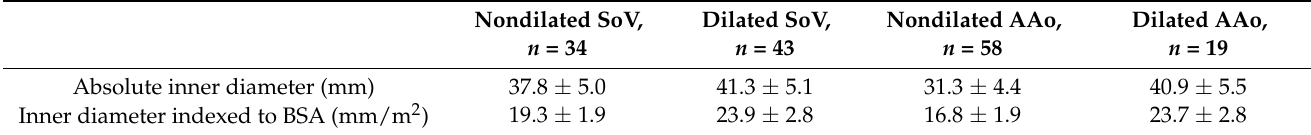
Nondilated SoV, Dilated SoV, Nondilated AAo, Dilated AAo, n = 34 n = 43 n = 58 n = 19